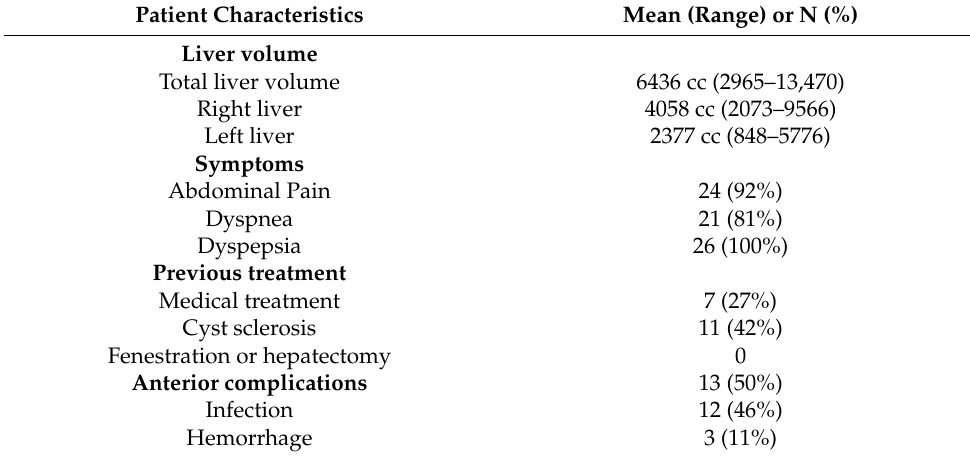
Table 2. Patients